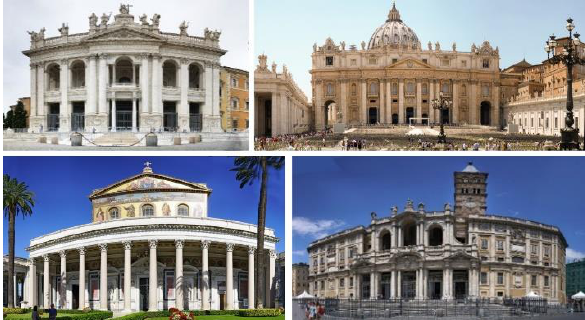
Figure 2- The four papal Basilicas; from top left clockwise: San Giovanni Laterano, San Pietro, Santa Maria Maggiore, San Paolo Outside the Wall.